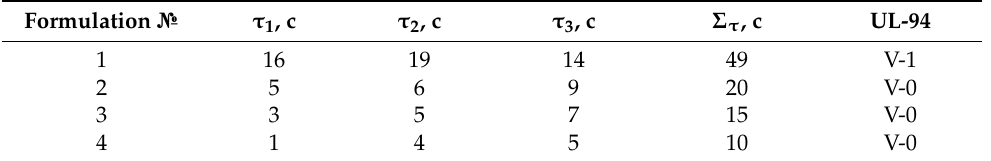
Table 6. Flammability test results according to UL-94 standard. Formulation